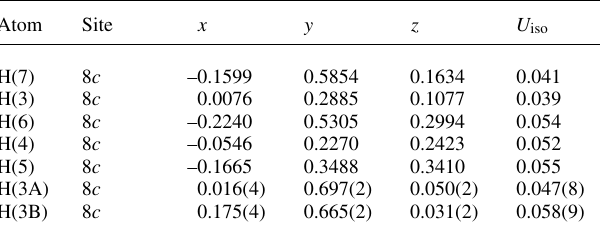
Table 2. Atomic coordinates and displacement parameters (in Å 2 )